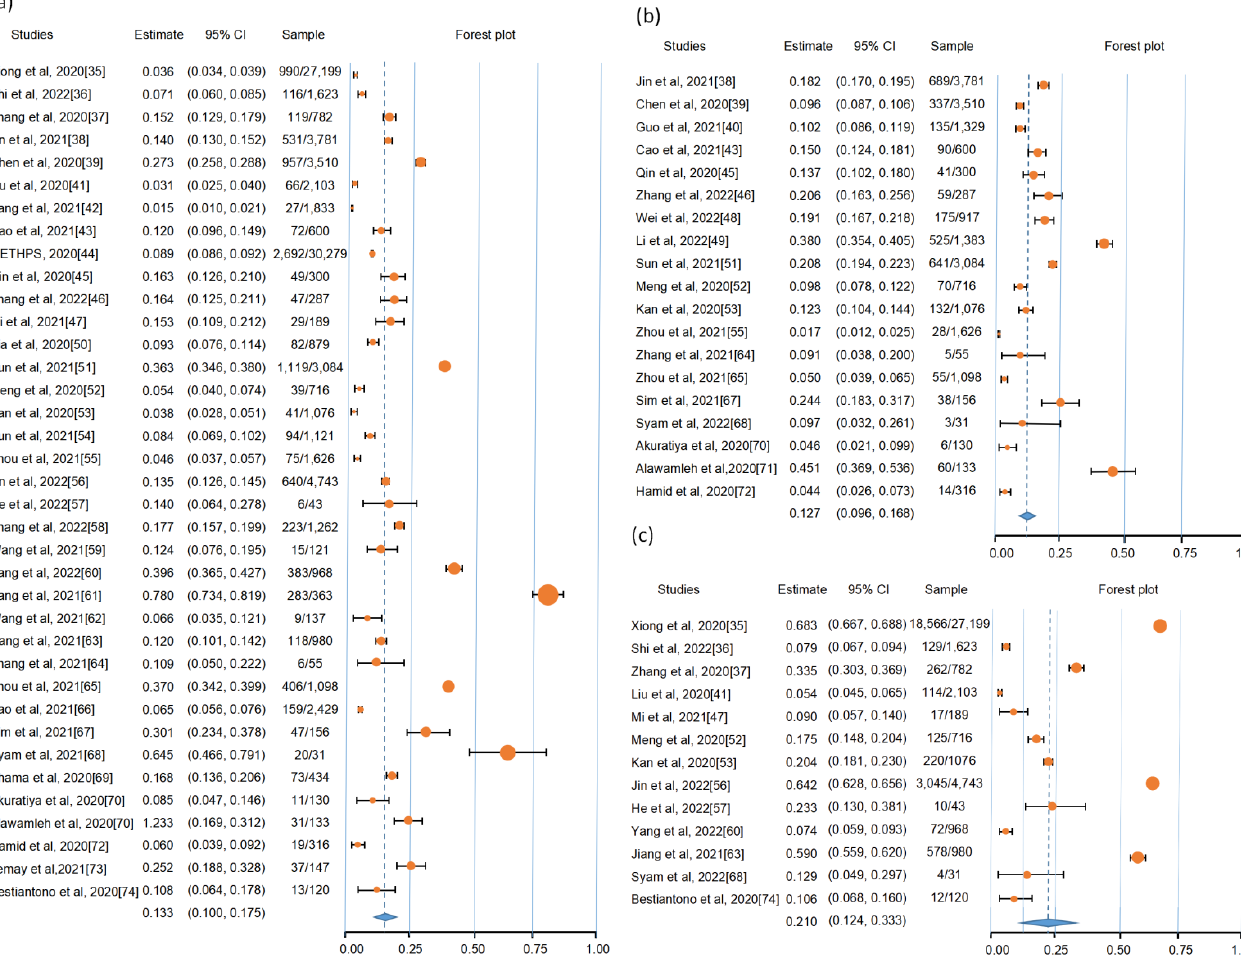
effect towards corresponding study, with the large circle size representing a high effect size.